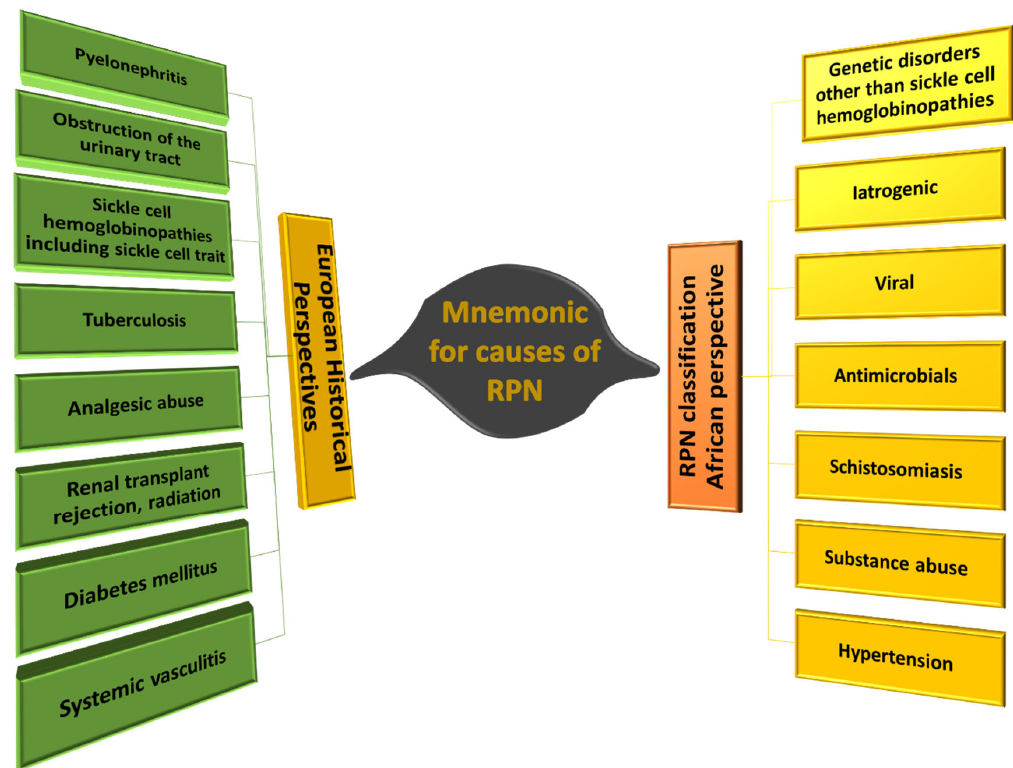
Figure 6. Additional suggested mnemonic RPN risk factors. Histologically, RPN is characterized by several features with the main initiator being coagulative necrosis of the renal papilla and the me ‐